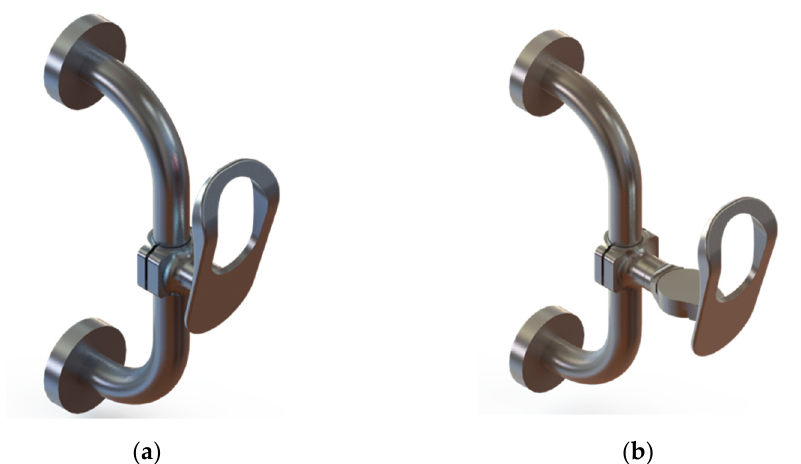
Figure 10. Visualization of the systems clamped to a D-type handle: ( a ) short-fixed; ( b ) dynamic.